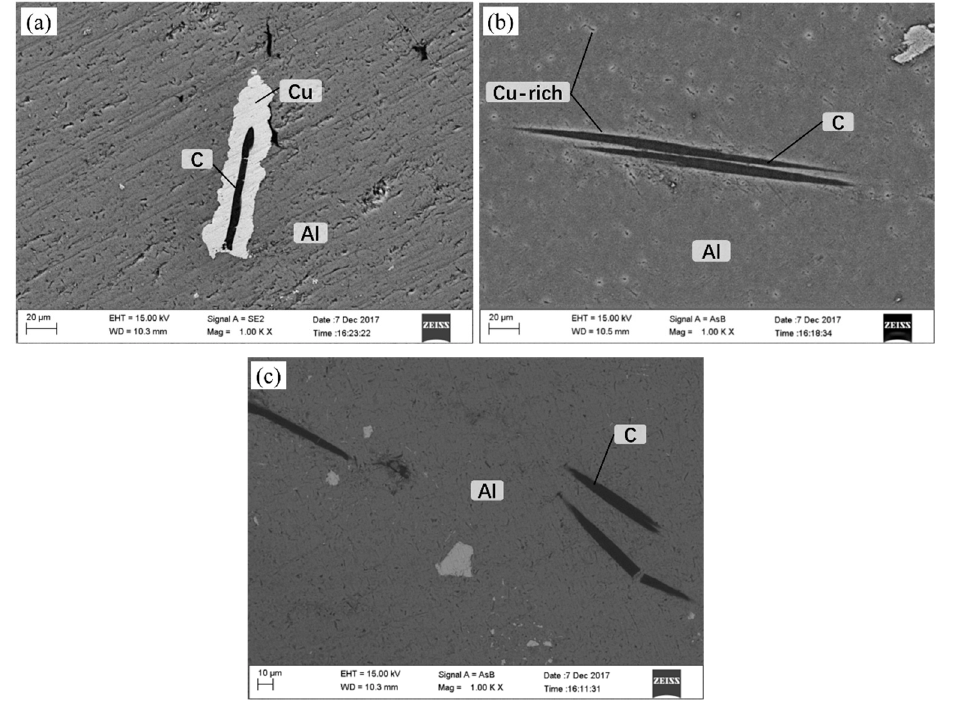
Figure 4. SEM micrograph of the C f with heat treatment of ( a ) atmospheric temperature; ( b ) 570 °C, 15 min; and ( c ) 600 °C, 15 min.